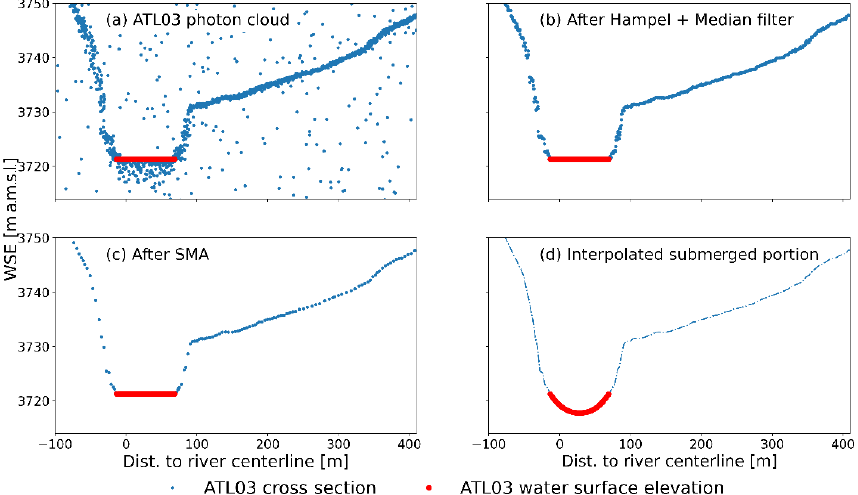
Figure 3. ATL03 photon cloud where the water surface is identified (a) . The outliers are removed using Hampel and median filters (b) . Smoothing of the cross section with SMA (c) . Interpolation of the submerged portion (d)